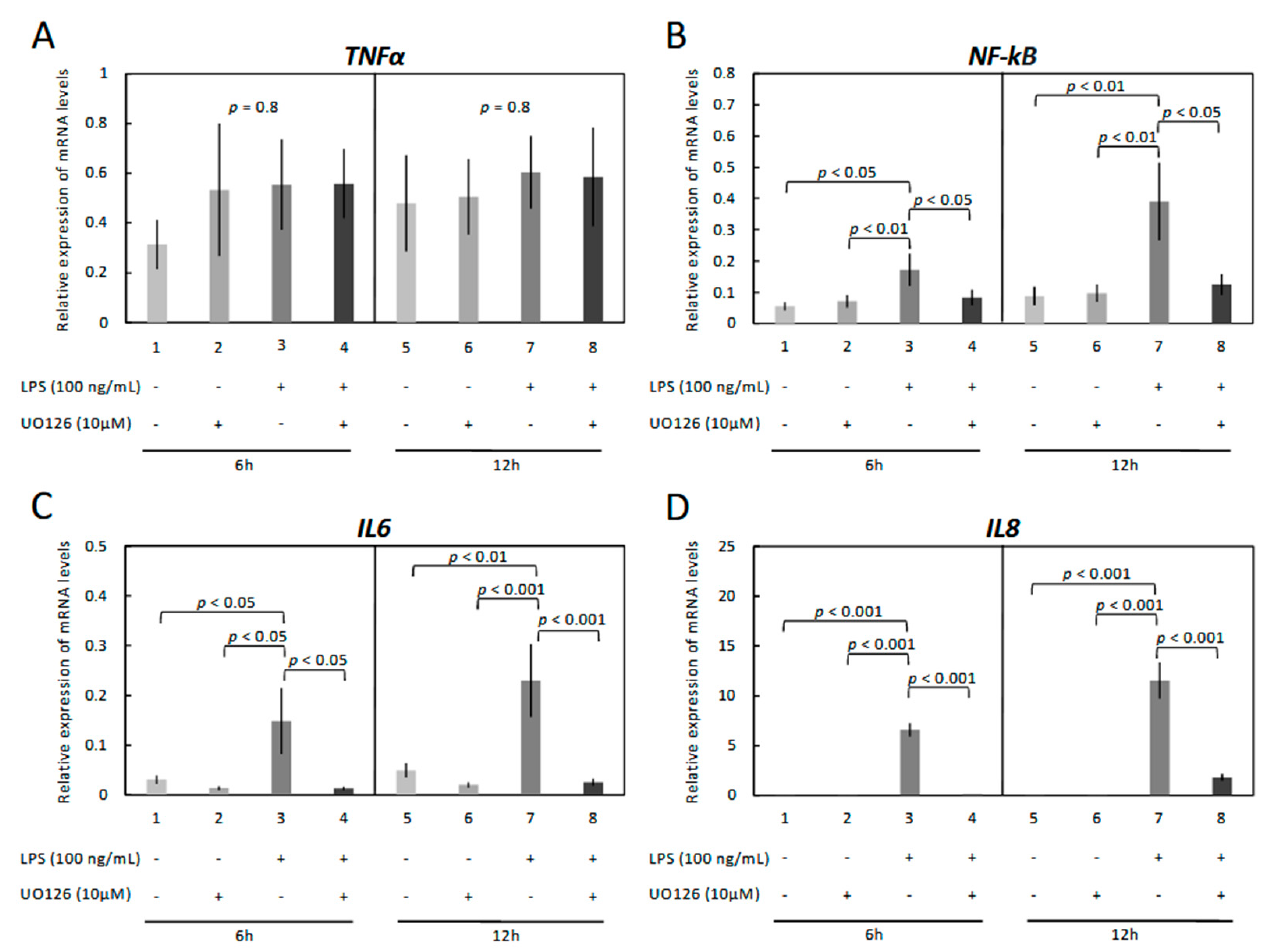
Figure 5. Effects of LPS treatment and inhibition of MAPK (UO126) activity on expression of TNF α , NF-kB , IL6 and IL8 in immortalized OLENDO cells. Expression of TNF α ( A ), NF-kB ( B ), IL6 ( C ), and IL8 ( D ) as determined by real-time (TaqMan) PCR. Inhibition of MAPK (UO126) activity was performed as described in the Materials and Methods. A parametric one-way ANOVA was applied followed by the Tukey–Kramer multiple comparisons post-test. All numerical data are presented as the means ± S.D. p -values < 0.05 were considered significant and are indicated.